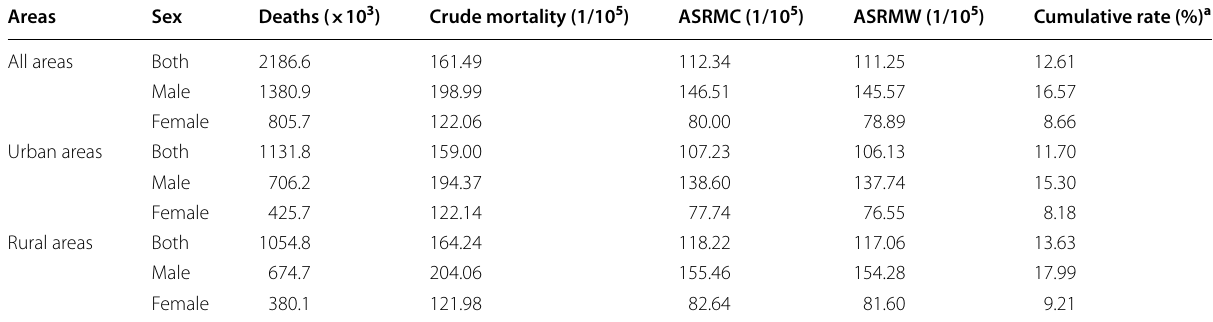
Table 2 Cancer mortality in China in 2012 (This table has been published previously and is reproduced with permission from the Chinese Journal of Cancer Research , see Ref. [3])